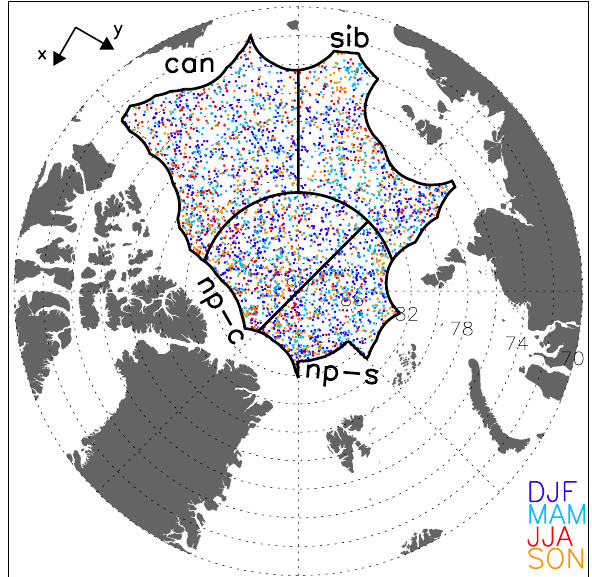
Fig. 1. Study area with spatial and seasonal distribution of the cy- clone detections (dots) for the period 2006–2008. The orientation of the ( x , y ) coordinate axes is shown in the upper left